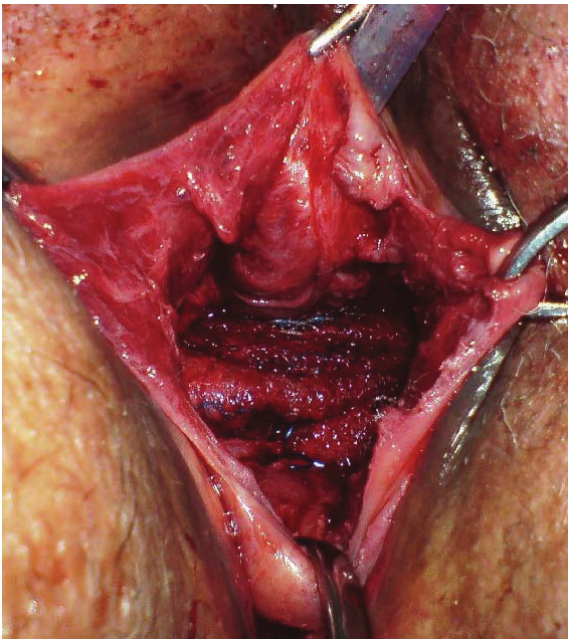
Figure 1: Bladder dissected from the anterior vaginal wall and 3 of the 4 cannulas and retrieval device in Prolift anterior mesh. Figure 2: Prolift in place after reduction of the